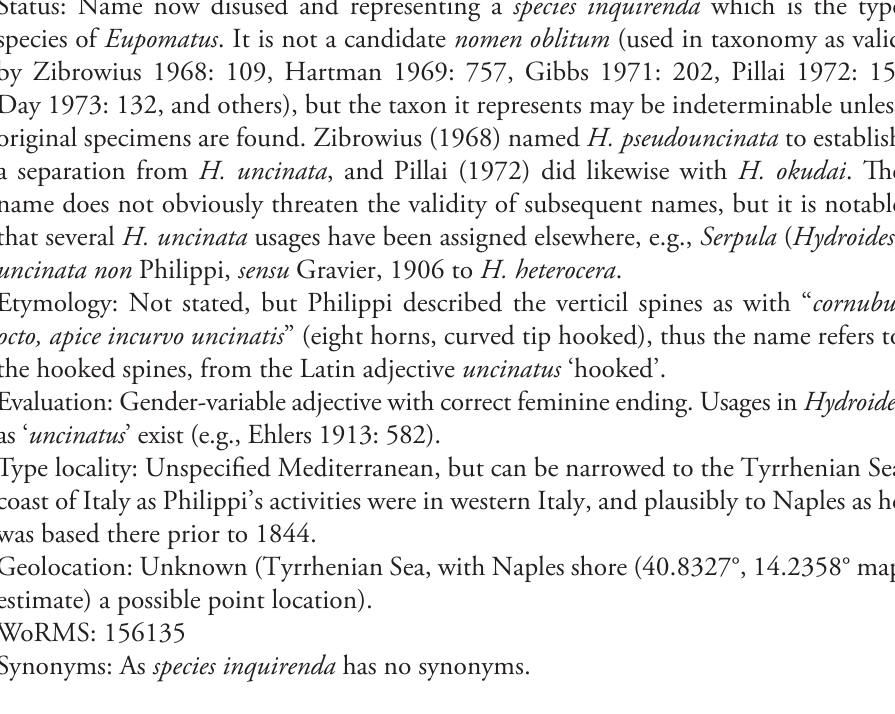
Evaluation: Gender-variable adjective with correct feminine ending. Usages in